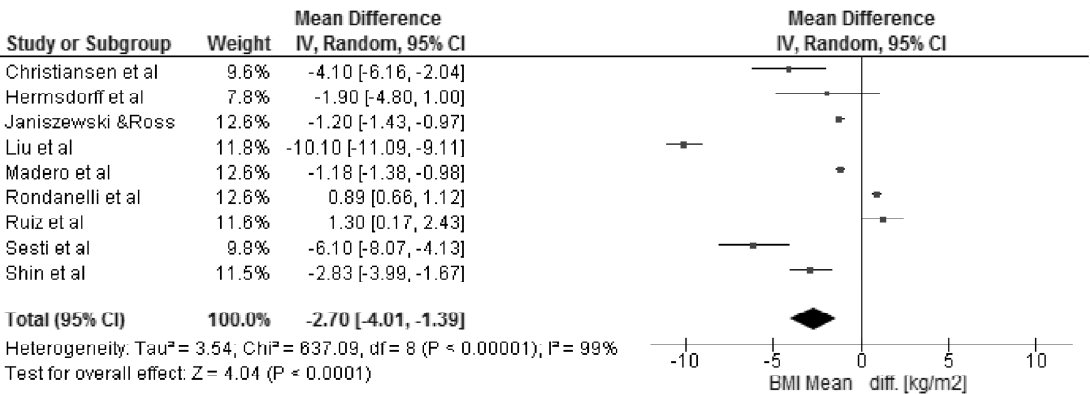
Figure 3. Forest plot of the random-effects meta-analysis of changes in BMI according to reduction in energy intake shown as polled standard differences in the means with 95% Cis and in randomized and non-randomized trials. * For each study, the square represents the point estimate of the intervention effect. Horizontal lines join the lower and upper limits of the 95% CI of this effect. The area of shaded squares reflects the relative weight of the study in the meta-analysis. Diamonds represent the subgroup mean difference and pooled mean differences. CI indicates confidence interval.